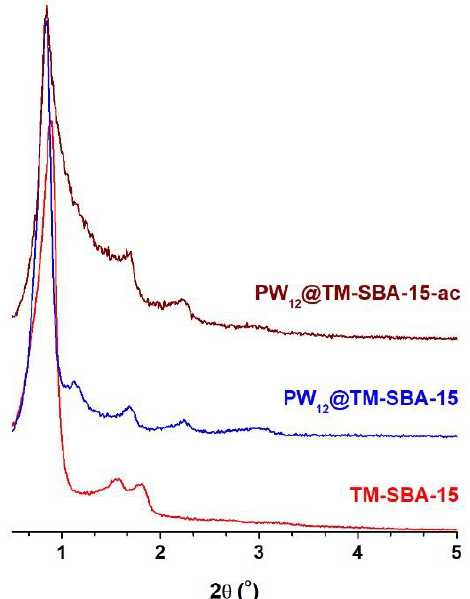
Figure 2. Powder XRD patterns of amine-functionalized SBA-15 (TM–SBA-15) and the corresponding PW 12 @TM–SBA-15 composite before and after catalysis (abbreviated as ac).